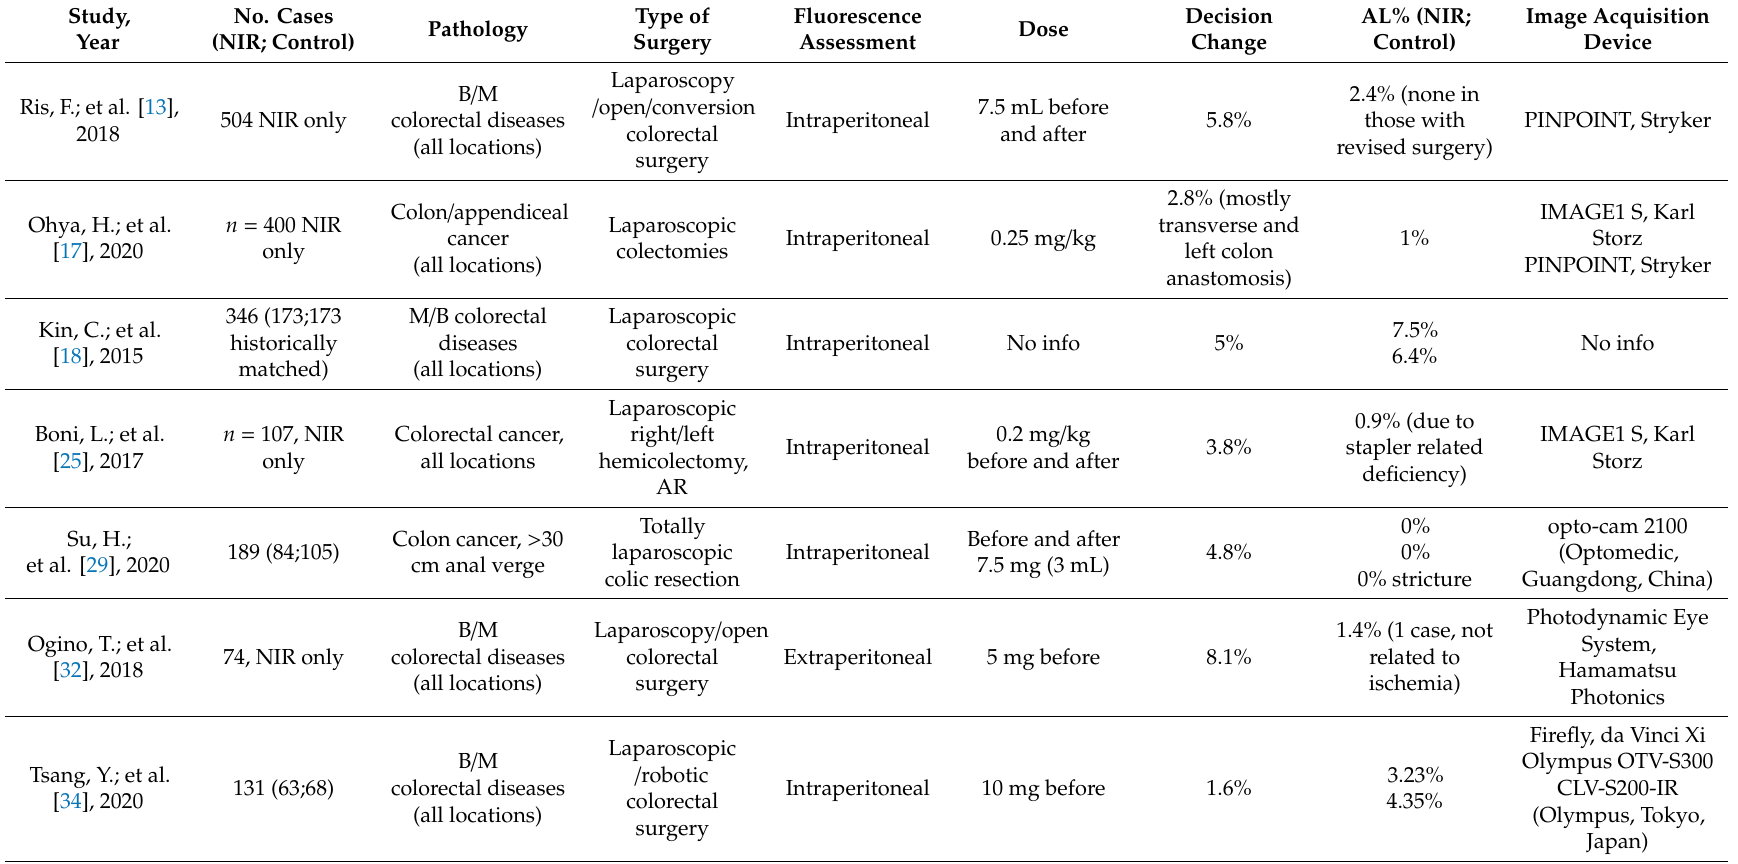
Table 1. Clinical studies regarding the role of near-infrared (NIR) indocyanine green (ICG) in preventing anastomotic leaks (AL) post-colorectal surgery; the first nine studies [13,17,25,29,32,34–36] refer to the use of ICG in all colorectal diseases; the following 14 refer to left colon and rectal surgeries only [19–24,26–28,30,31,33,37,38].